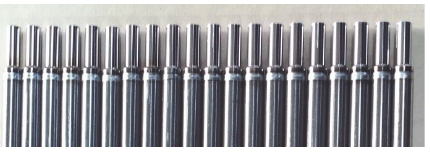
Figure 15: Dummy fuel elements welded by